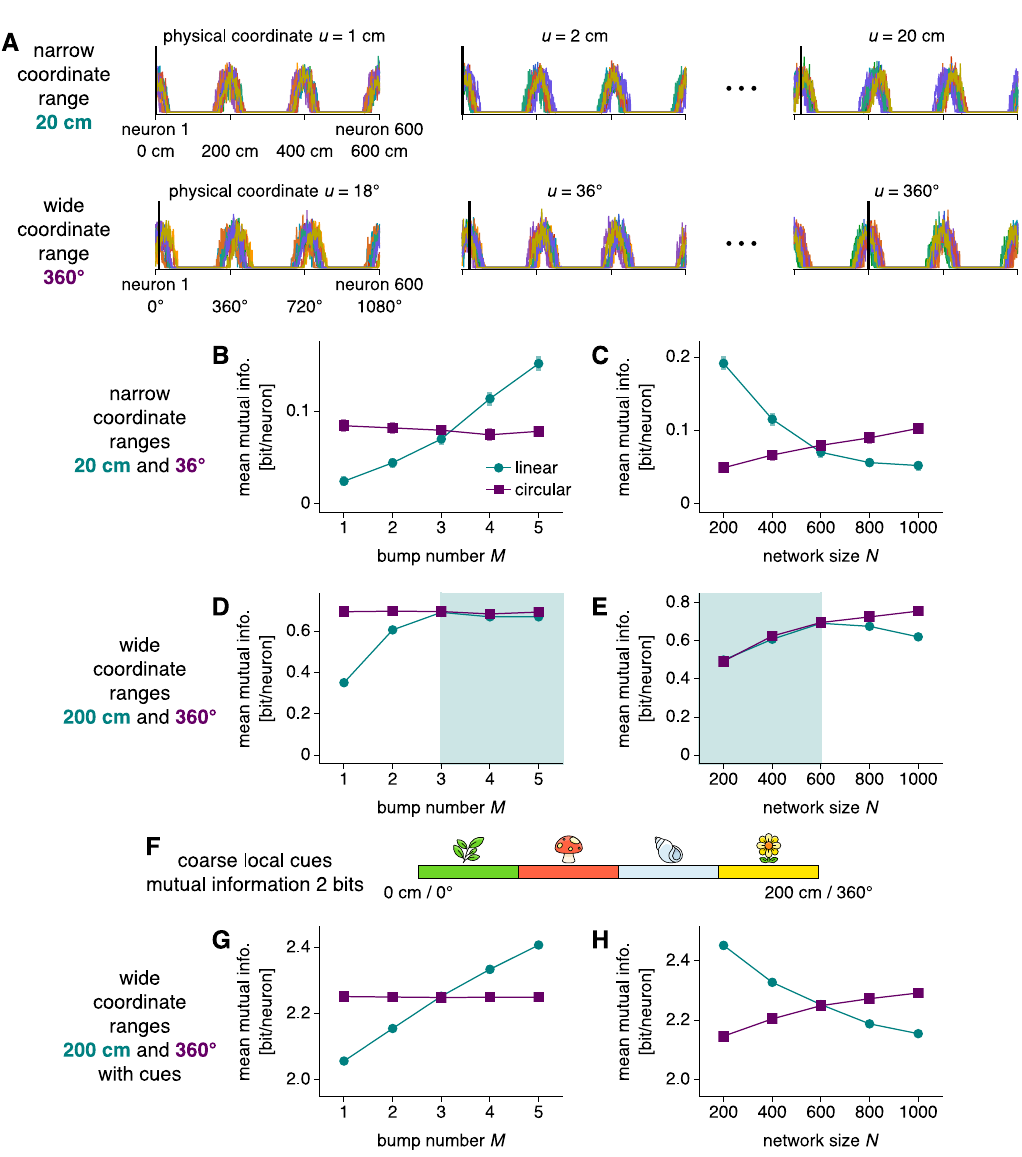
Fig 6. Mutual information between neural activity and physical coordinates with input noise of magnitude σ = 0.5. ( A ) To compute mutual information, we initialize replicate simulations without input drive at different coordinate values (thick black lines) and record the final neural activities (thin colored lines). The physical coordinate can be linear or circular and its range can be narrow or wide; here, we illustrate two possibilities for networks with 600 neurons and 3 bumps. ( B and C ) Mutual information between physical coordinate and single-neuron activity under narrow coordinate ranges. ( B ) Information increases with bump number for linear coordinates and remains largely constant for circular coordinates. Networks with 600 neurons. ( C ) Information decreases with network size for linear coordinates and increases for circular coordinates. Networks with 3 bumps. ( D and E ) Mutual information between physical coordinate and single-neuron activity under wide coordinate ranges. The trends in B and C are preserved for circular coordinates. They are also preserved for linear coordinates, except for the shaded regions in which the coordinate range exceeds the bump distance. ( F ) Coarse local cues are active over different quadrants of the wide coordinate ranges. ( G and H ) Mutual information between physical coordinate and the joint activities of a single neuron with the four cues in F under wide coordinate ranges. The trends in B and C are preserved for both linear and circular coordinates. Points indicate data from 96 replicate simulations at each coordinate value averaged over neurons and bars indicate bootstrapped standard errors of the mean. Cue icons adapted from Streamline Freemoji (CC BY license, https://www.